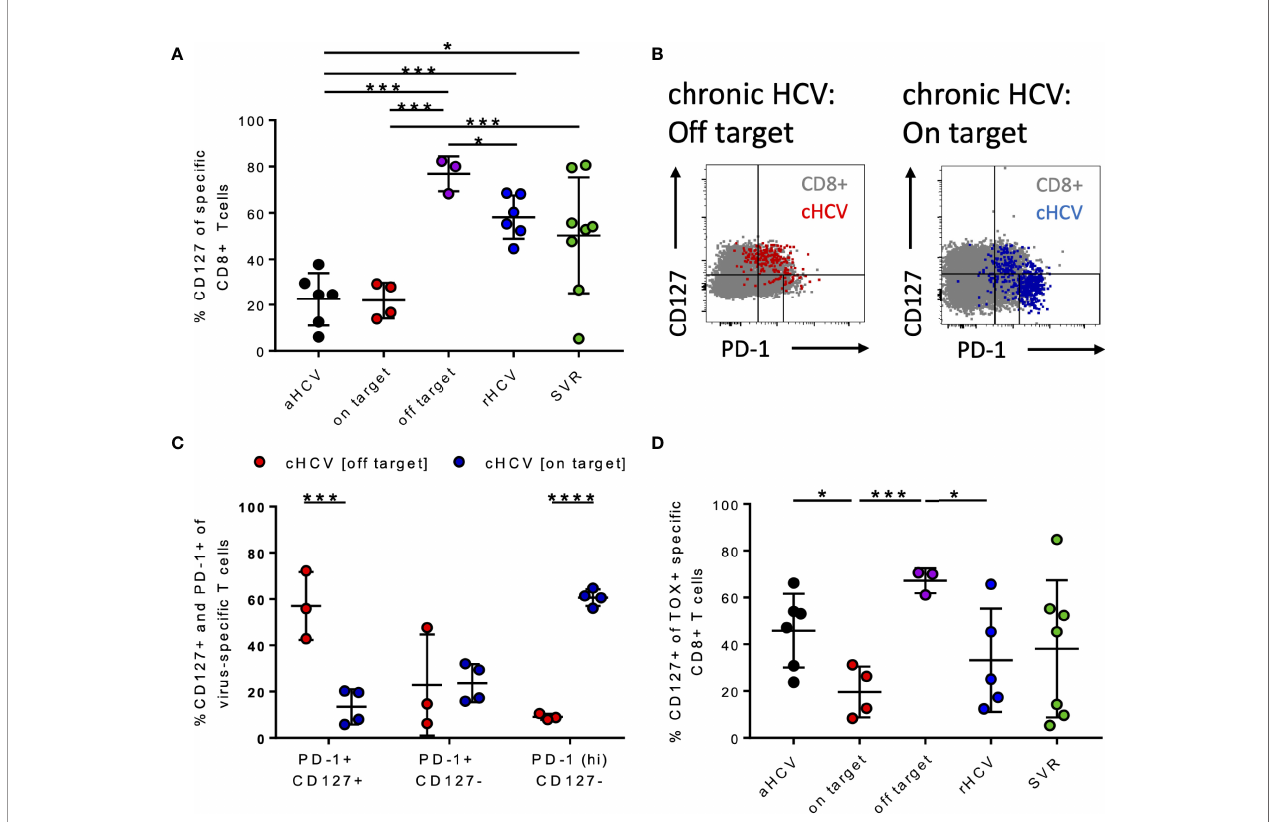
FIGURE 4 | (A – D) Differentiation status of HCV-speci fi c CD8+ T cells at different stages of HCV infection. (A) Frequency of CD127+ virus-speci fi c CD8+ T cells at the different stages of HCV infection. (B) Representative dot plots for CD127 and PD-1 co-expression (gray: bulk population, red: cHCV off-target, blue: cHCV on- target). (C) Frequency of PD-1+ CD127+, PD1+ CD127-, and PD1 hi CD127- virus-speci fi c CD8+ T cells in chronic HCV. (D) Frequency of CD127+ TOX+ virus- speci fi c CD8+ T cells at all the different stages of hepatitis C infection; aHCV, acute HCV; chronic HCV with on-target T cells = on target, chronic HCV with